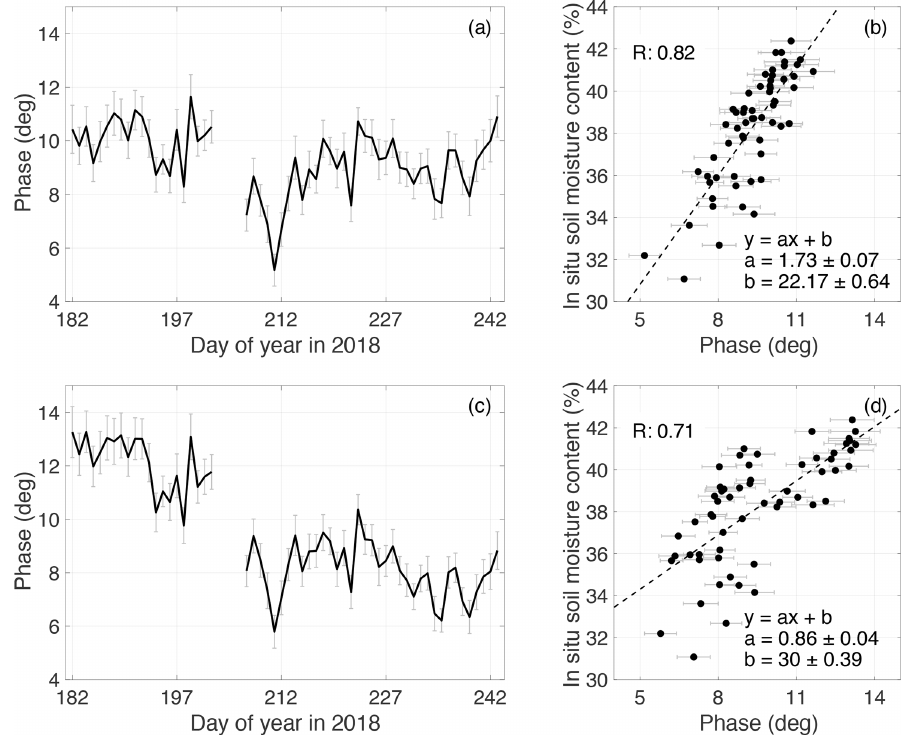
Figure 7. (a) Time series of the phases derived by our method during DOY 182–243 in 2018. Error bars denote their uncertainties represented by the standard deviations of the mean values. (b) Scatter plot between phases in panel (a) and in situ soil moisture and their best linear fit shown as a dashed line. The slope and intercept of the fit line are presented. We also show the goodness of fit as R . Panels (c) and (d) are similar to panels (a) and (b) respectively but for the results of the default method. The data gap during DOY 203–206 is due to the absence of SNR